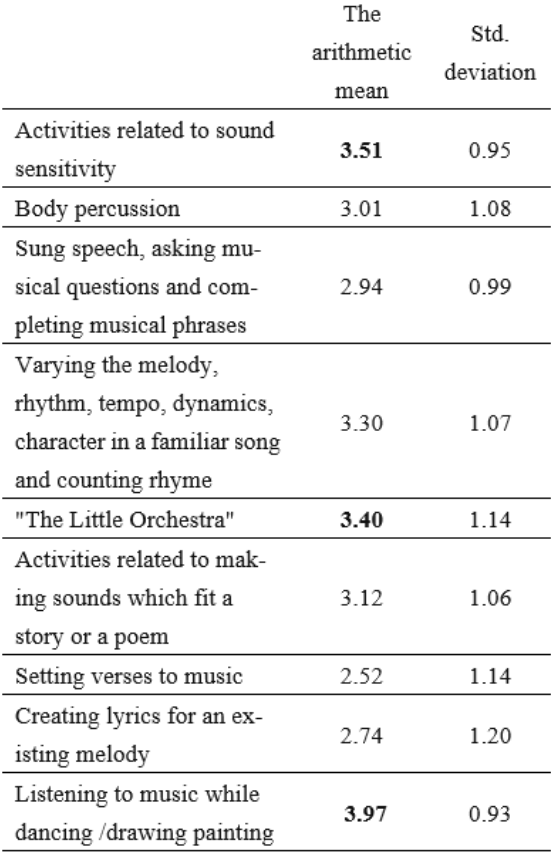
Table 4. Frequency of conducting cre